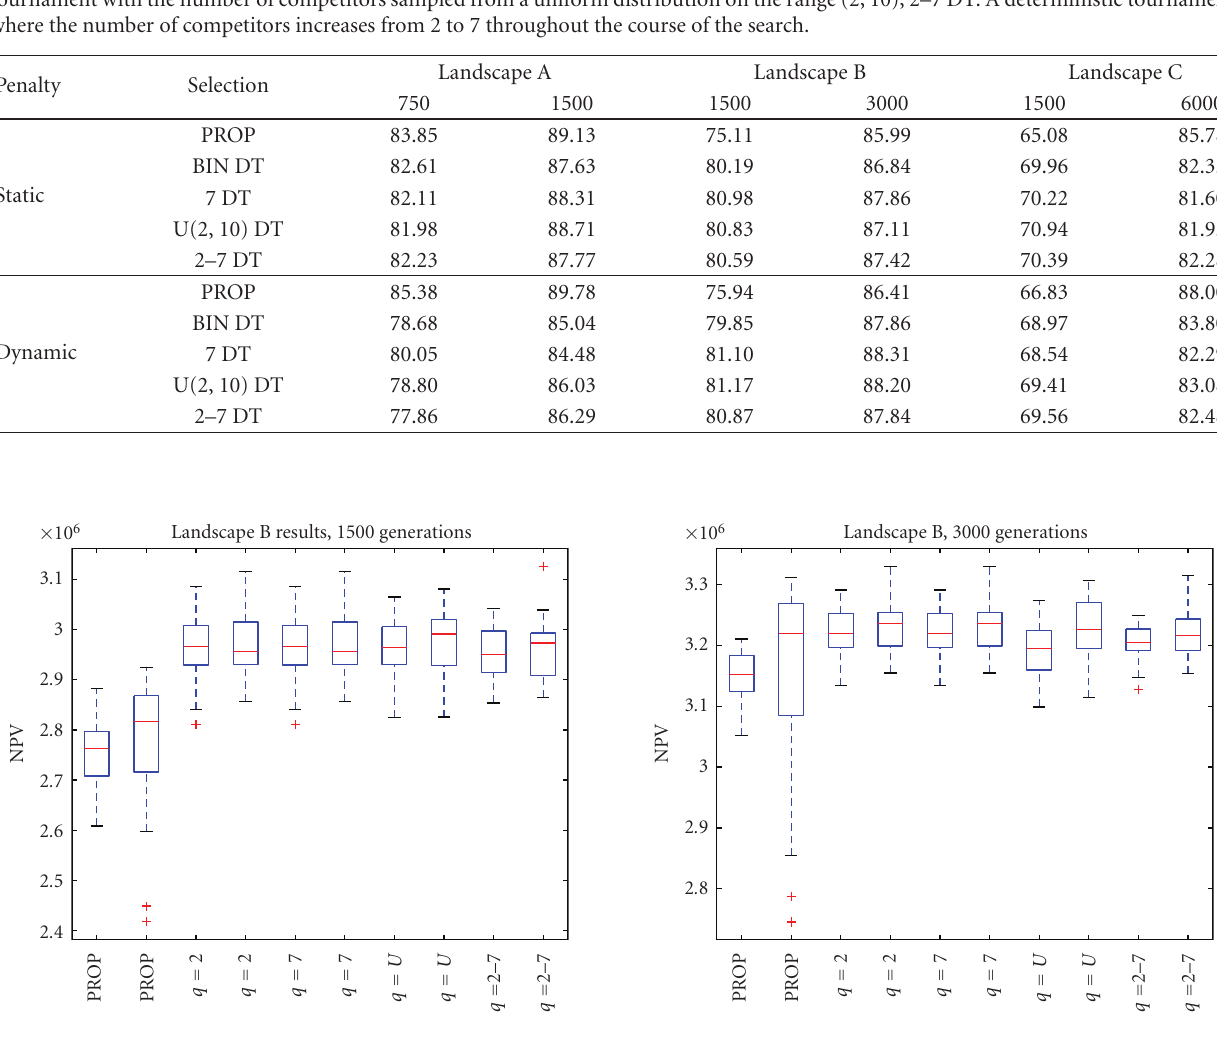
Figure 3: Results for Landscape B, 1500 generations. This figure presents a box-plot of solution quality (NPV; y -axis) for each paired selection/penalty strategy tested. The x -axis displays the strategy; static and dynamic penalty strategies for the same selection strategy are displayed side by side (static on the left side). Reading from left to right, the first selection strategy presented is proportional selection and the rest are deterministic tournaments with various competitor pool sizes ( q ). The label “ q = U ” corresponds to the strategy wherein q was sampled from a uniform distribution over the range (2, 10), and the label “ q = 2–7” corresponds to the strategy where q increased from 2 to 7 during the search.